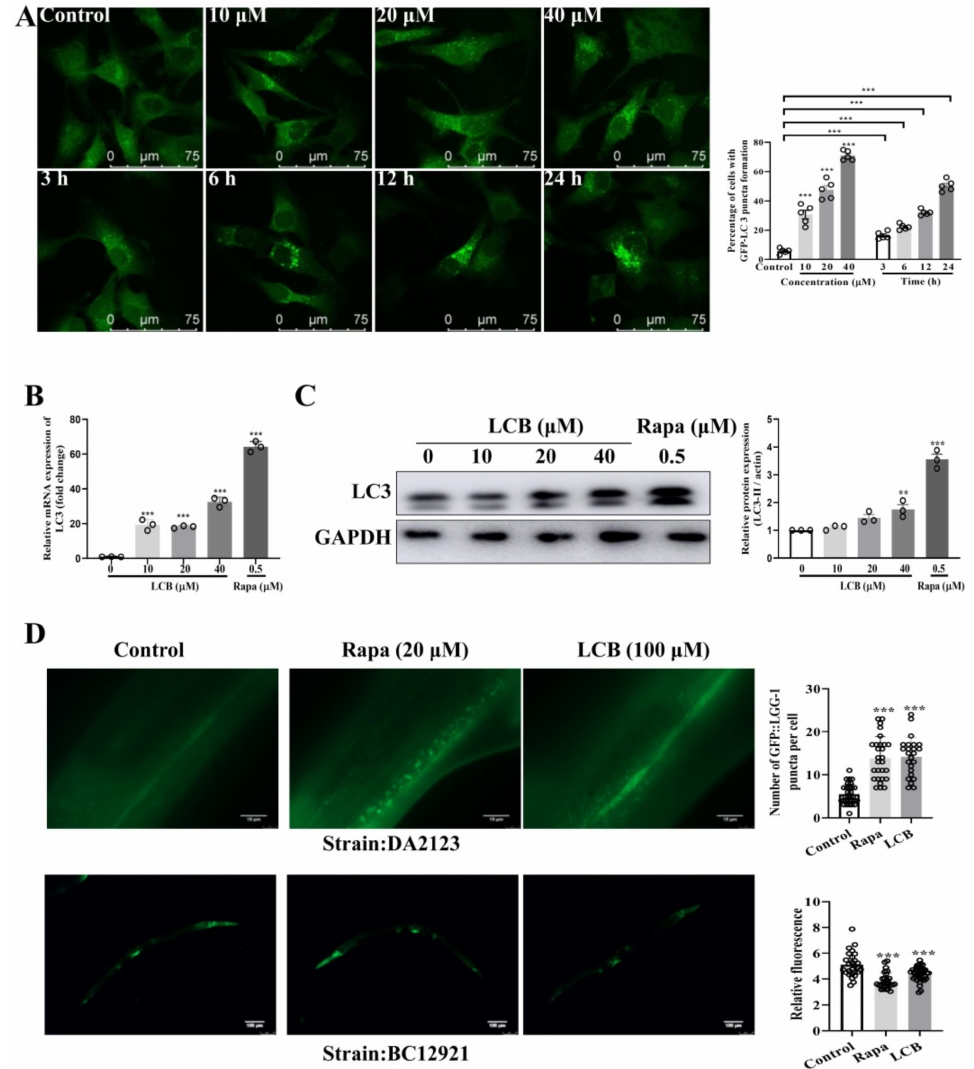
Figure 5. LCB enhanced autophagy in GFP–LC3–U87 stable cells and C. elegans models. ( A ) GFP– LC3–U87 cells were exposed to various concentrations of LCB (10 to 40 µ M) for 24 h or various treatment durations (3 to 24 h) of LCB (20 µ M), as indicated. Punctate GFP–LC3 were calculated from the counts in five randomly selected visual fields. Representative fluorescence images with punctate GFP–LC3 are shown. Scale bar = 75 µ m, *** p < 0.001. ( B ) Real time (RT)–PCR and ( C ) Western